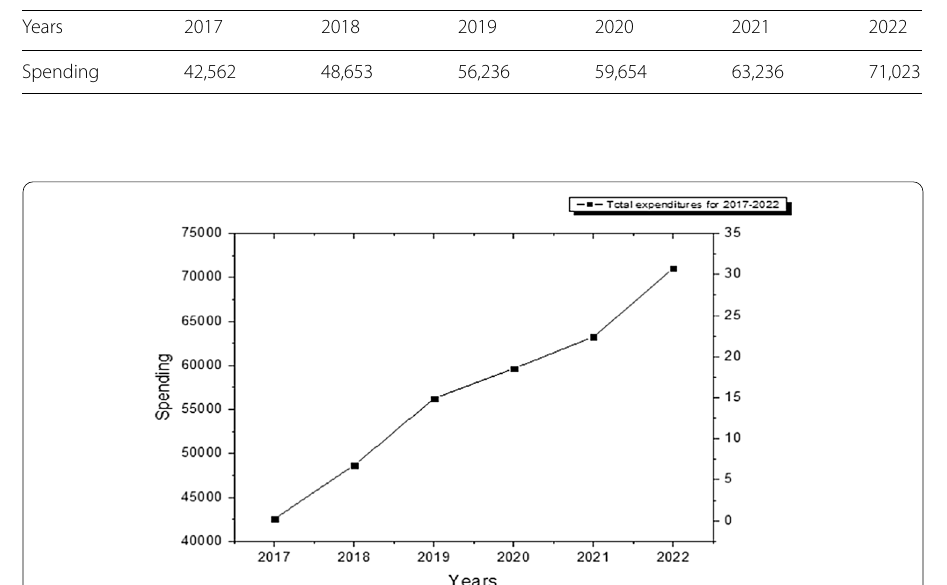
Fig. 10. 2017–2022 total domestic tourism expenditure